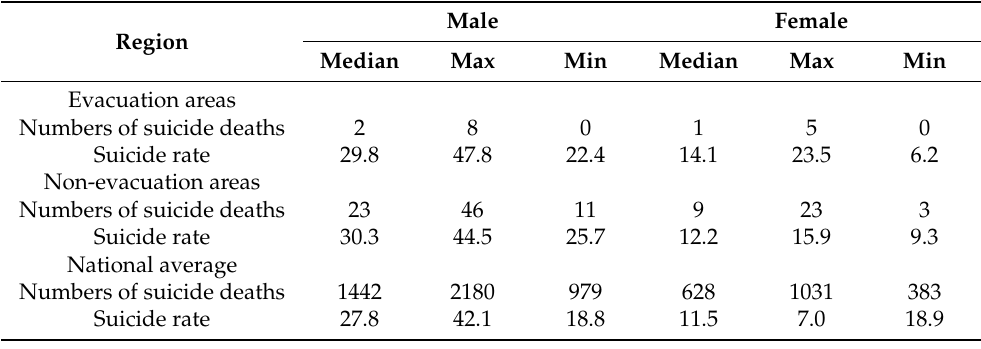
Table 1. Numbers and rates of suicide by month in evacuation areas, areas outside those, and